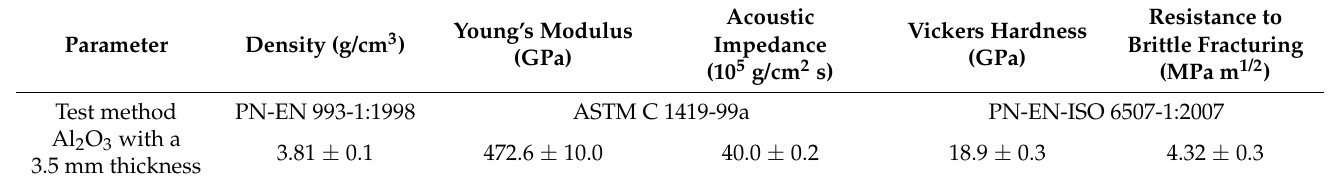
Table 3. Physical and mechanical parameters of the Al 2 O 3 ceramics (CeramTec, Plochingen,